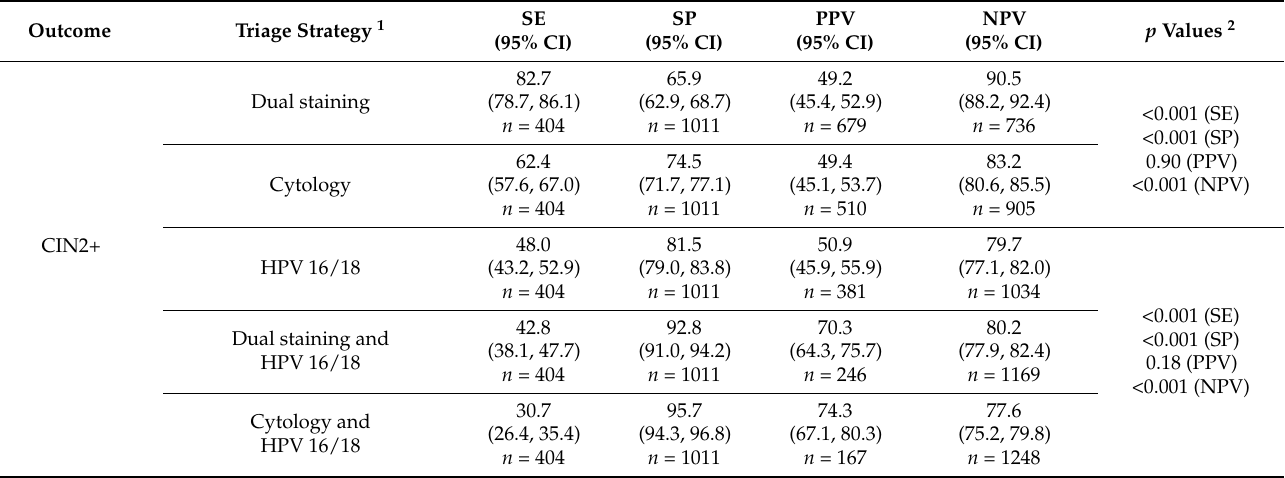
Table 2. Performance of p16/Ki-67 dual staining as compared to cytology for triage of CIN2+ and CIN3+, alone or in combination with partial HPV genotyping in a cohort of primary high-risk HPV positive women ( n = 1415).